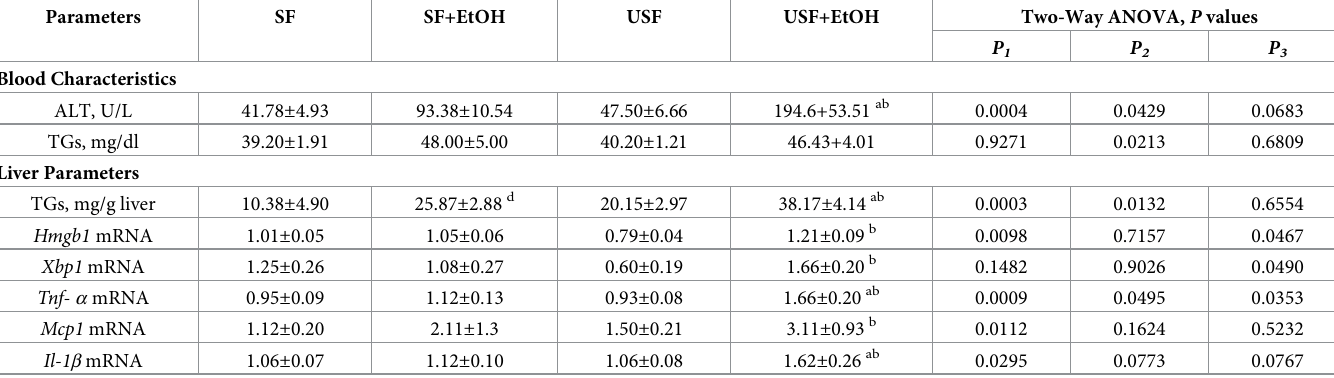
Table 1. Characteristics of liver injury caused by chronic-binge ethanol exposure and dietary USF or SF.